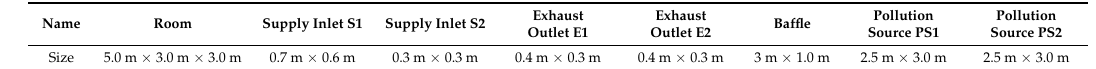
Figure 6. Physical Model I. Table 2. Physical parameters of Model I.